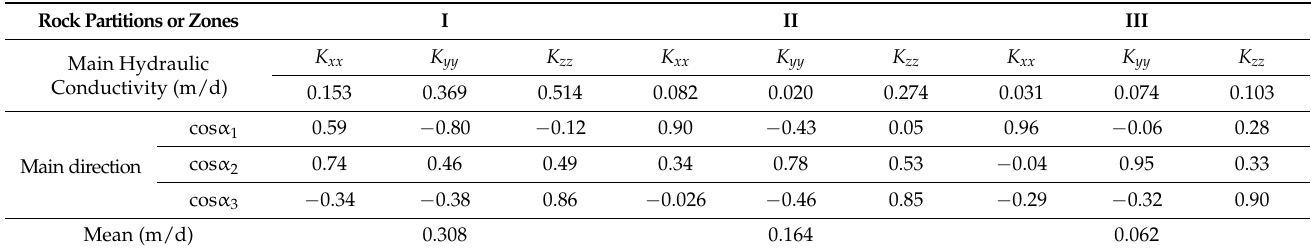
Table 3. Inverse values of main hydraulic conductivity and main direction of rock